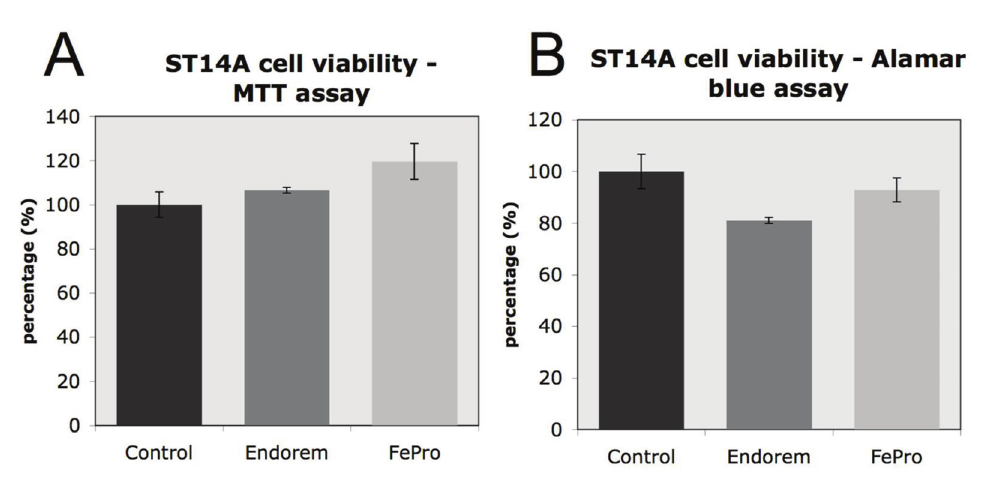
Figure S1. Effect of FePro- and Endorem-labelling on ST14A viability, and growth. A , MTT assay. No decrease in the percentage of viable ST14A cells is observed between control, Endorem-, and FePro-labelled cells after 24 hour treatment with MRI contrast agents; a small increase is observed in FePro-labelled cells (p<0.05). B , Alamar Blue assay. No significant difference is observed between FePro-labelled and control unlabelled cells, but there is a decrease in metabolic activity of Endorem-labelled cells relative to control unlabelled cells